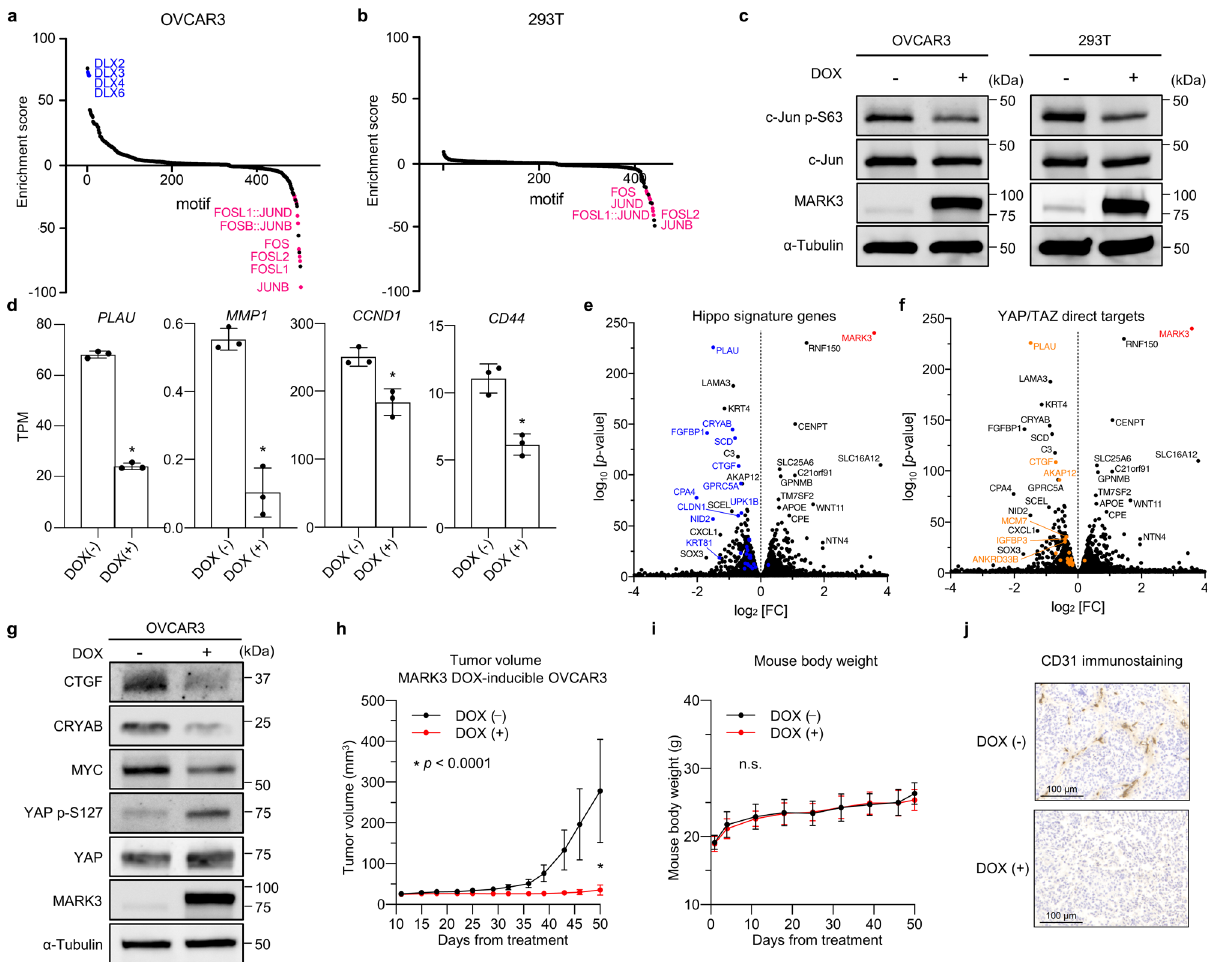
Fig. 6 MARK3 regulate AP-1 and Hippo signaling target genes. a , b ATAC-seq analysis. Ranking of the most differential motifs in response to MARK3 overexpression in OVCAR3 ( a ) and 293T ( b ) cells. In both cell lines, the activities of transcription factors, which make up the AP-1 complex, such as the Jun family and Fos family, are signi fi cantly decreased. Jaspar core non-redundant motifs are included in this motif enrichment analysis. c Immunoblotting shows that MARK3 overexpression in OVCAR3 and 293T cells decreases the phosphorylation of c-Jun, indicating that MARK3 antagonizes the activity of the AP-1 complex. d RNA-seq analysis. Representative AP-1 target genes are downregulated upon MARK3 overexpression. Error bars represent mean ±SD of three biological replicates. Statistical analysis was performed using unpaired Student ’ s t -test (* P < 0.01). e , f RNA-seq analysis. Volcano plot demonstrates that MARK3 overexpression in OVCAR3 cells downregulates both Hippo signature genes ( e ) and YAP/TAZ target genes ( f ). g Immunoblotting shows that MARK3 overexpression in OVCAR3 cells inhibits nuclear translocation of YAP and decreases the protein expression of Hippo signaling target genes, such as CTGF and MYC. h , i Mouse xenograft experiment using MARK3 DOX-inducible OVCAR3 cells. The growth curves of the tumor volume ( h ) and the bodyweight ( i ) distribut i on of mouse xenografts. n = 10 in DOX-negative group and n = 10 in DOX-positive group. Error bars represent mean ± SD. Statistical analysis was performed using an unpaired Student ’ s t -test. j Representative images of CD31 immunohistochemistry of mouse xenografts with or without DOX